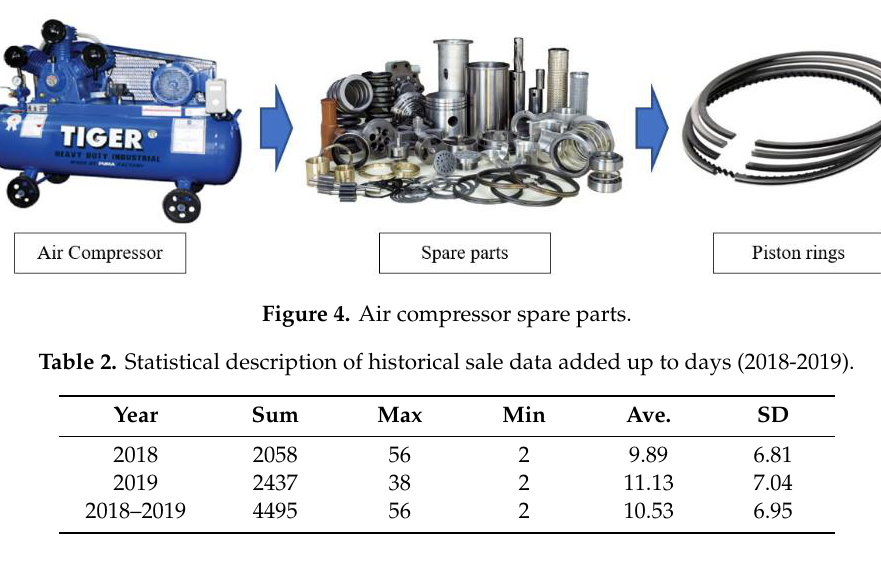
Table 2. Statistical description of historical sale data added up to days (2018-2019).